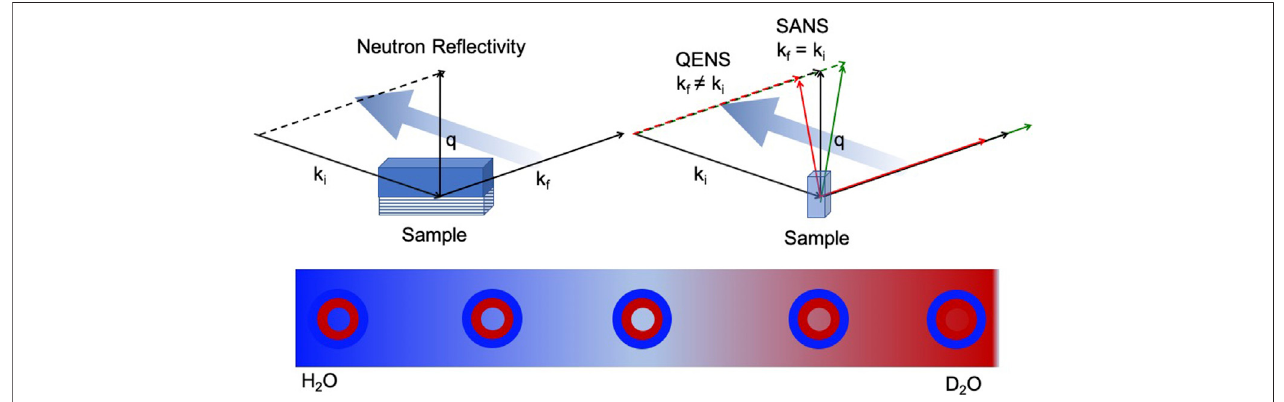
FIGURE 1 | Self assembled membranes are ubiquious in chemical systems, such as surfactant membranes, and biological systems as for example phospholipid membranes. Neutron re fl ectivity (left) and scattering (right) allows to study the structure and motion in a realistic environment, e.g., physiological conditions. By isotop substitution it is possible to highlight different parts of the sample under chemically quasi identical conditions (bottom)